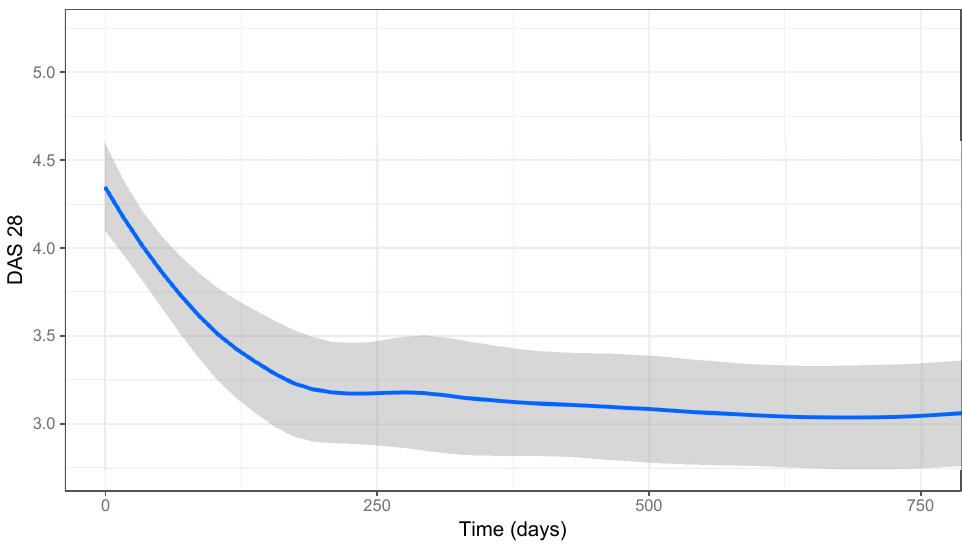
Figure 1. Disease activity: The average disease activity score (DAS28) level is shown for all rheumatoid arthritis (RA) patients treated with tofacitinib with a 95% confidence interval.